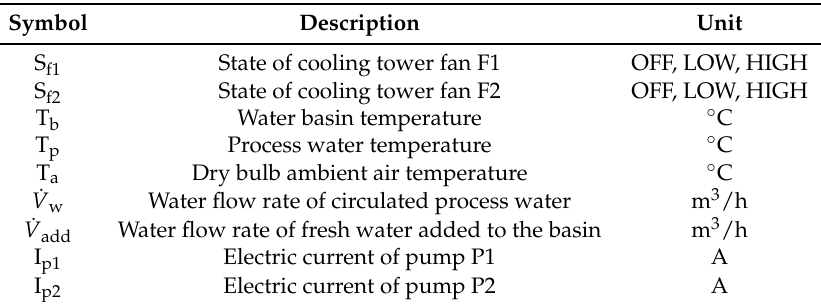
Table 1. Available data on the INEOS industrial